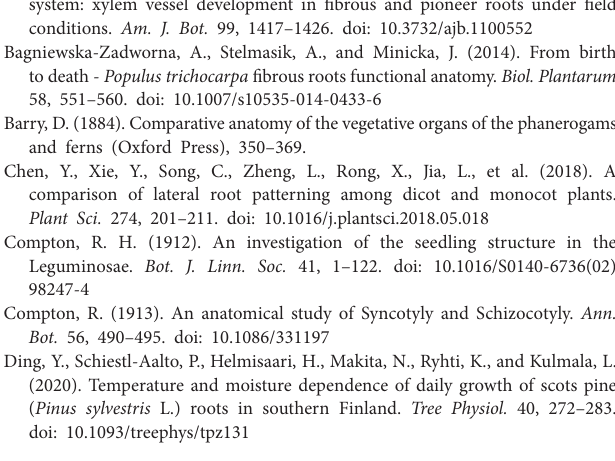
Supplementary Figure S1 | Typical fine roots with different root protoxylem groups and lateral primordium emerging from pericycle cell adjacent to the protoxylem poles in three hardwood